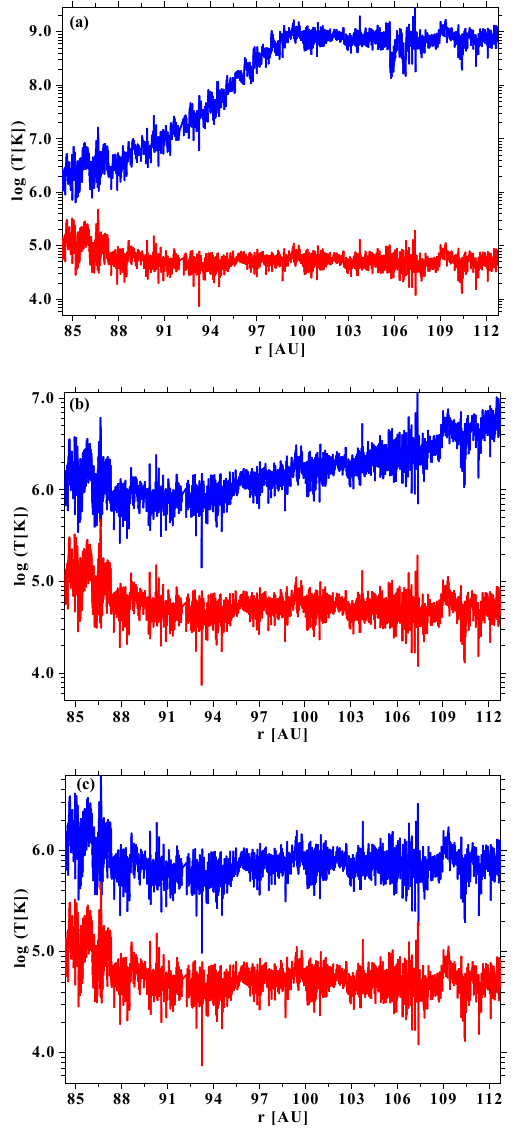
Figure 7. The estimated κ temperature (blue lines) using Eq. (17) and the κ parameter along the Voyager 2 trajectory as calculated by Fahr et al. (2016). The lower red curves are the Voyager data form NSSDC (http://omniweb.gsfc.nasa.gov/coho/form/voyager2.html). From top to bottom (a–c) , the diffusion coefficients as given in Fahr et al. (2016) change from D 0 = 10 − 8 , 10 − 9 , 10 − 10 cm 2 s − 3 , re-